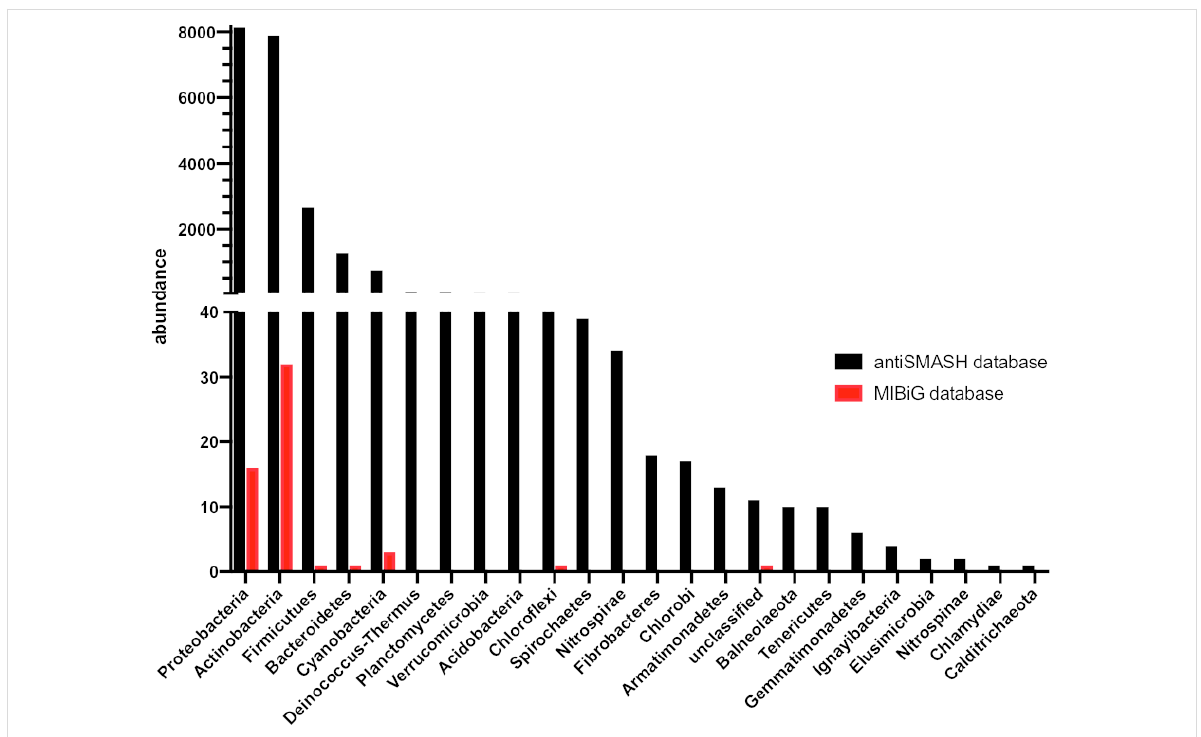
Figure 3: Abundance and distribution of bacterial terpene biosynthetic gene clusters as determined by genome mining (black) compared to experi- mentally characterized bacterial terpene BGCs (red).